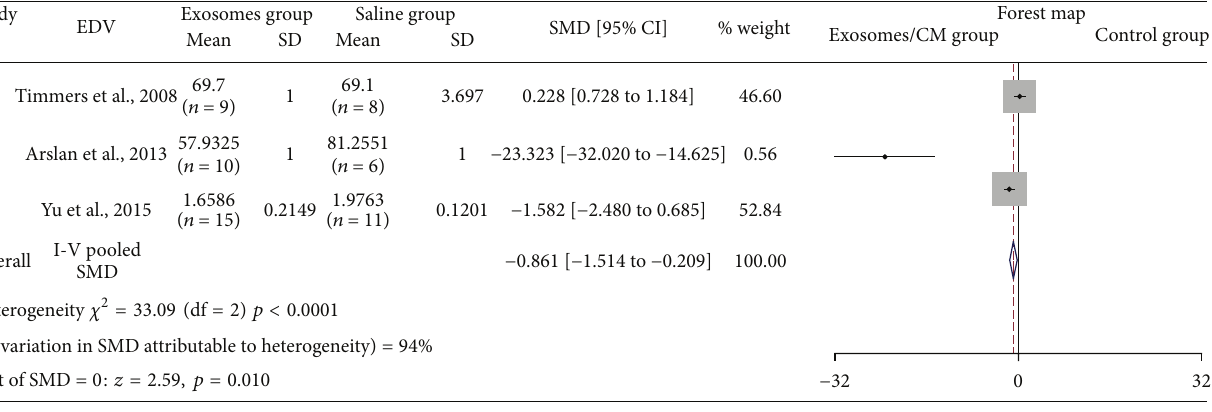
Figure 7: The effectiveness of exosomes on EDV.